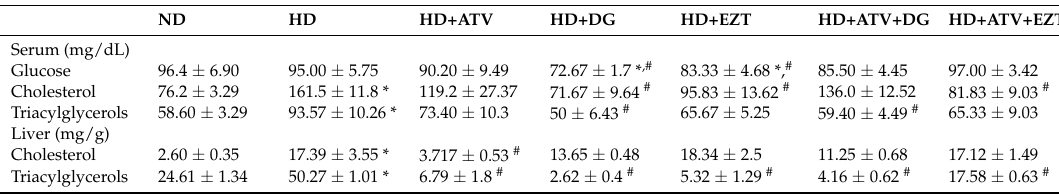
Values represent the mean ± SEM ( n = 6). * Statistically different from normal diet (ND), # Statistically different from hypercholesterolemic diet (HD), ( p < 0.05), by one-way ANOVA followed by Student–Newman–Keuls. HD+ATV: hypercholesterolemic diet + atorvastatin; HD+EZT: hypercholesterolemic diet + ezetimibe; HD+DG: hypercholesterolemic diet + diosgenin; HD+ATV+EZ: hypercholesterolemic diet + atorvastatin + ezetimibe; HD+ATV+DG: hypercholesterolemic diet + atorvastatin + diosgenin; dpm: disintegrations per